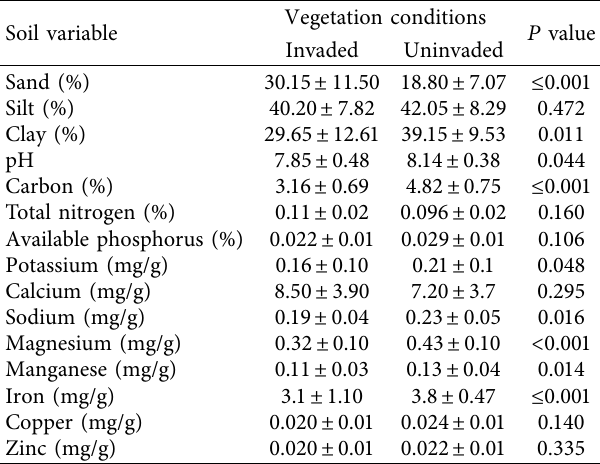
Table 3: Mean ( ± SD) physicochemical characteristics of soils under both invaded and uninvaded vegetation conditions and results of independent t -test (at α �